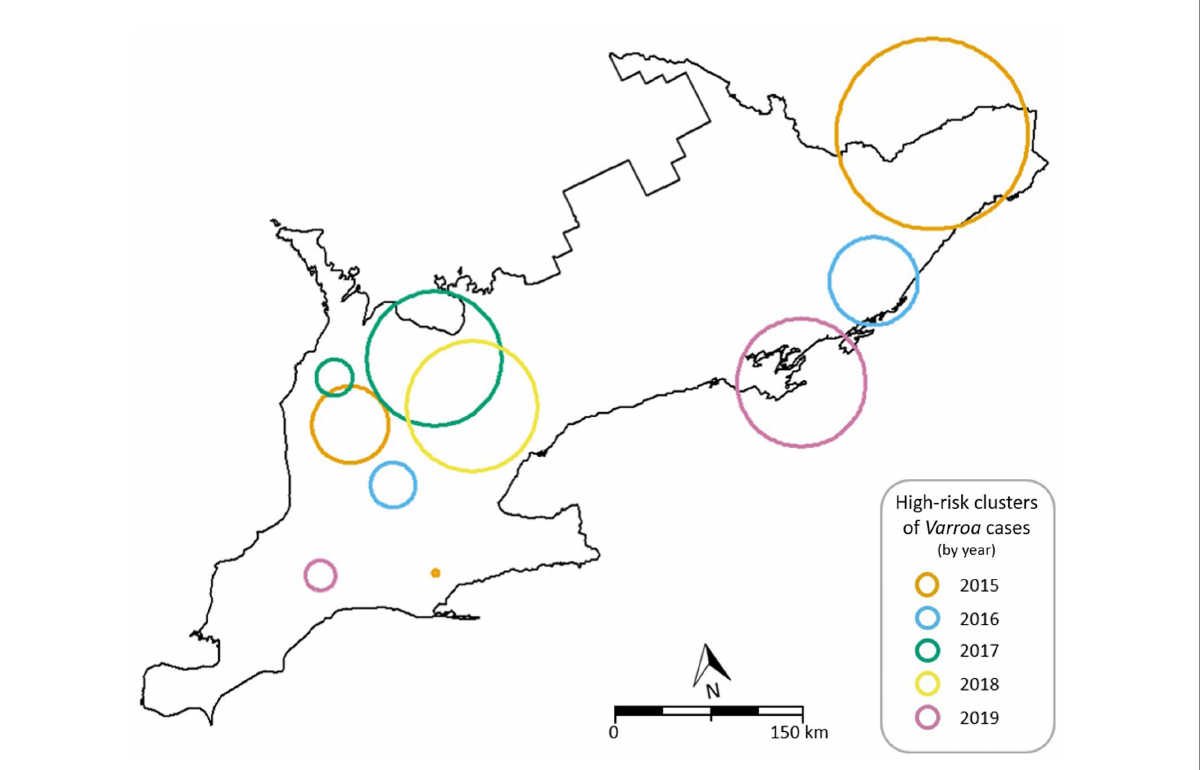
FIGURE 3 Map of the detected high-risk clusters of V. destructor cases by year in Southern Ontario using the spatial scan statistic.